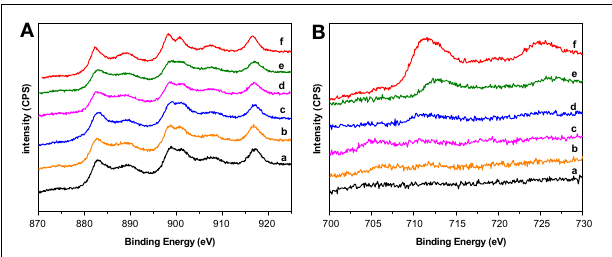
FIGURE 1 | XPS spectra of the prepared supports. (A) Ce3d region: (a) Ce/Al, (b) CeFe0.5/Al, (c) CeFe1/Al, (d) CeFe1.5/Al, (e) CeFe2/Al, (f) CeFe3/Al; (B) Fe2p región: (a) CeFe0.5/Al, (b) CeFe1/Al, (c) CeFe1.5/Al, (d) CeFe2/Al, (e) CeFe3/Al, (f) Fe/Al.